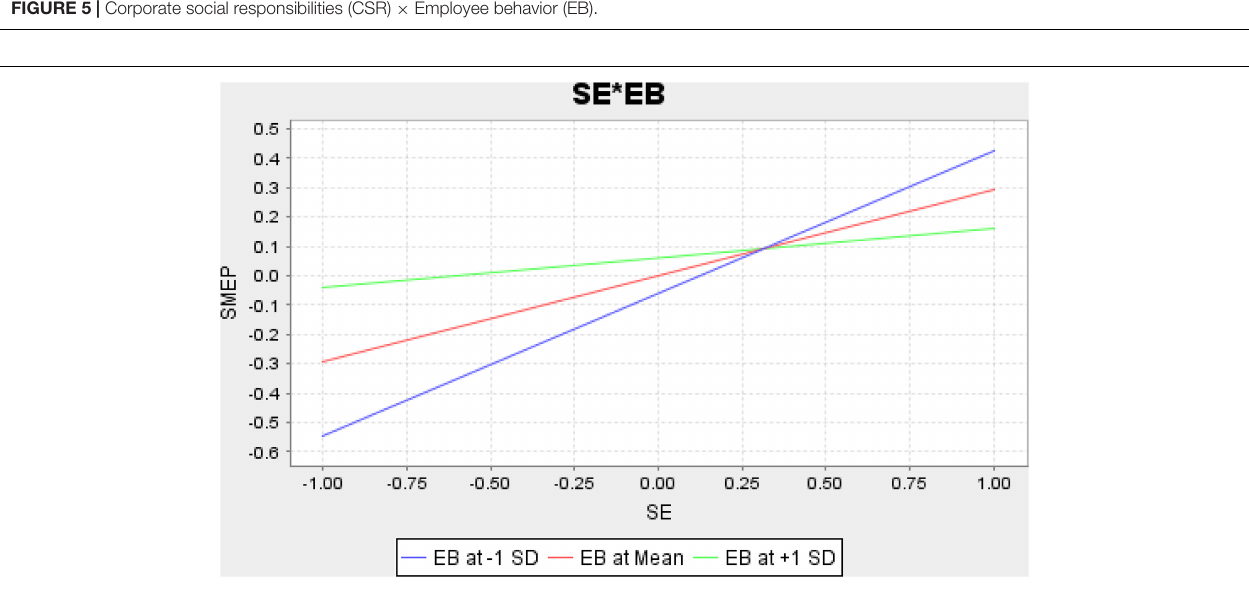
FIGURE 6 | Social entrepreneurship (SE) × Employee behavior (EB).